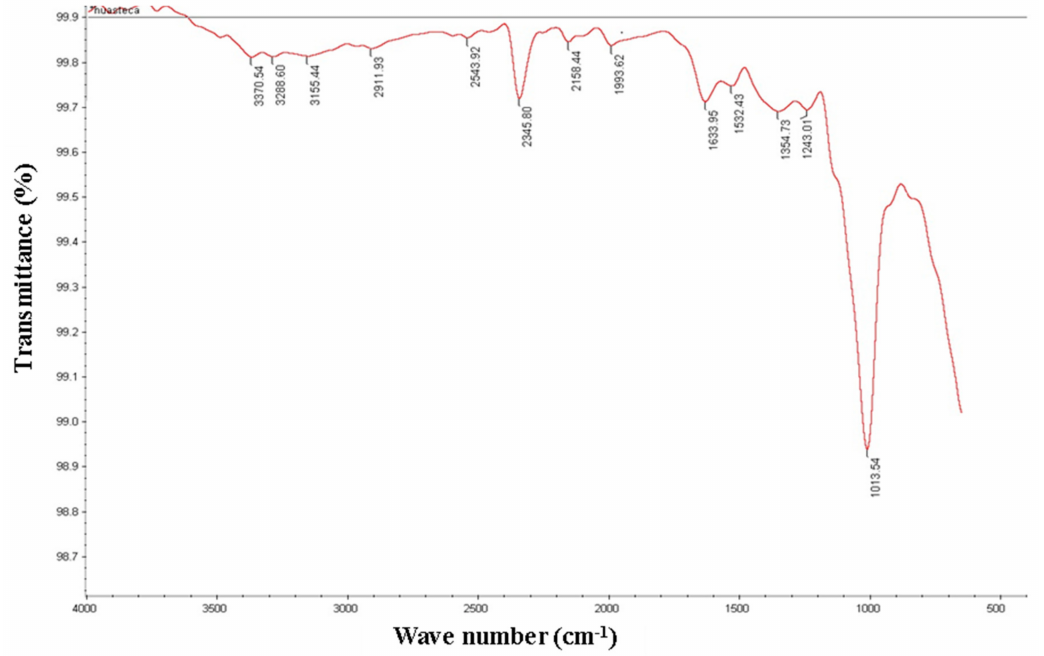
Figure 2. Jackfruit seeds flour spectra obtained using FTIR-ATR